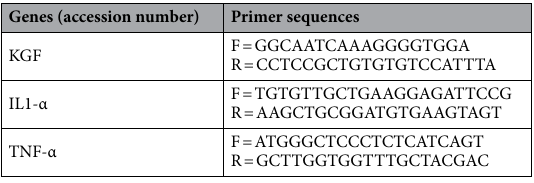
Table 2. The PCR